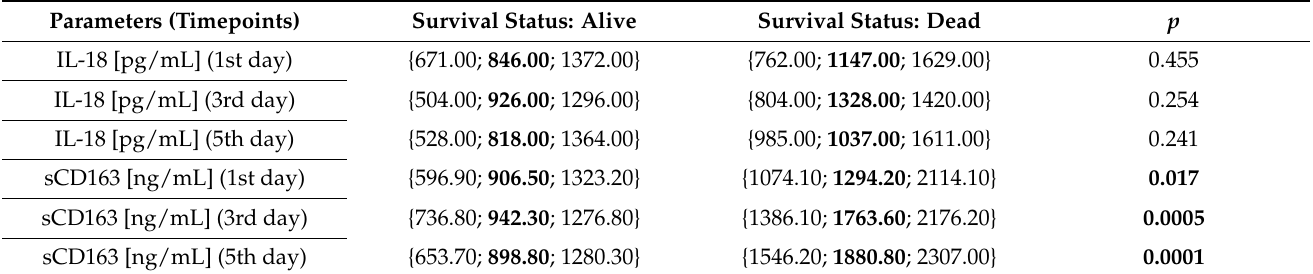
Table 5. Differences, among septic patients, in values of IL-18 and sCD163, in context of survival status and analysed timepoint (day of hospitalization).